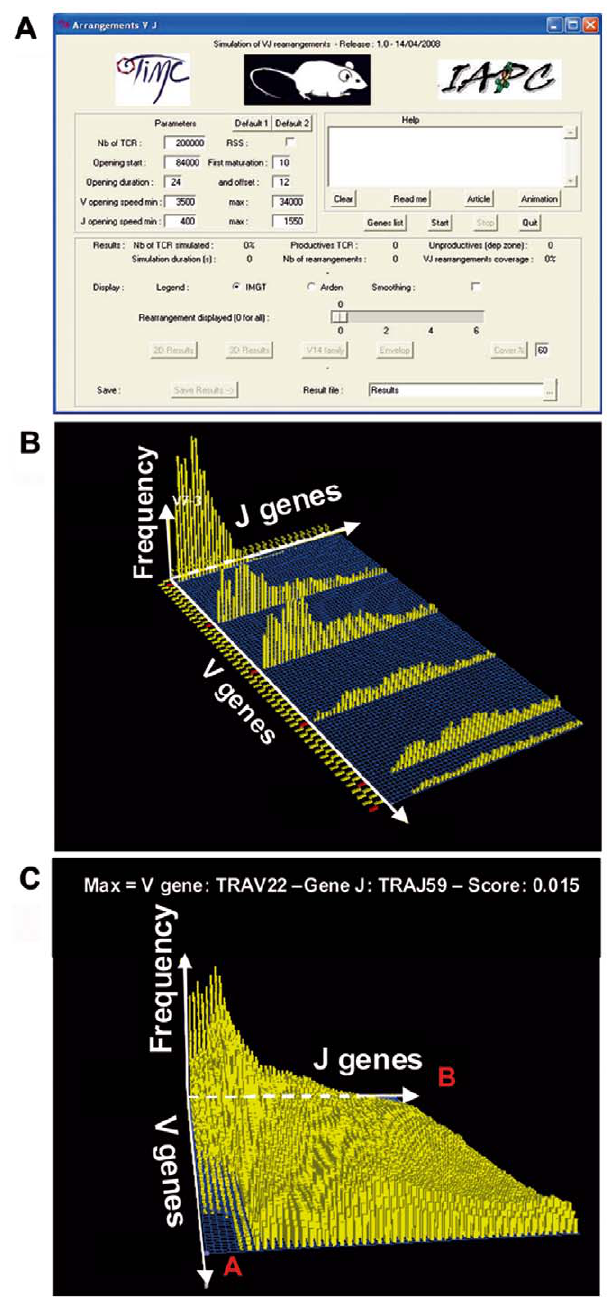
Figure 3. Model interface and results. (A) The main user interface window of the simulation program, (B) 2D representation of the rearrangement frequencies, (C) 3D representation of the rearrangement frequencies over all V and J gene associations.